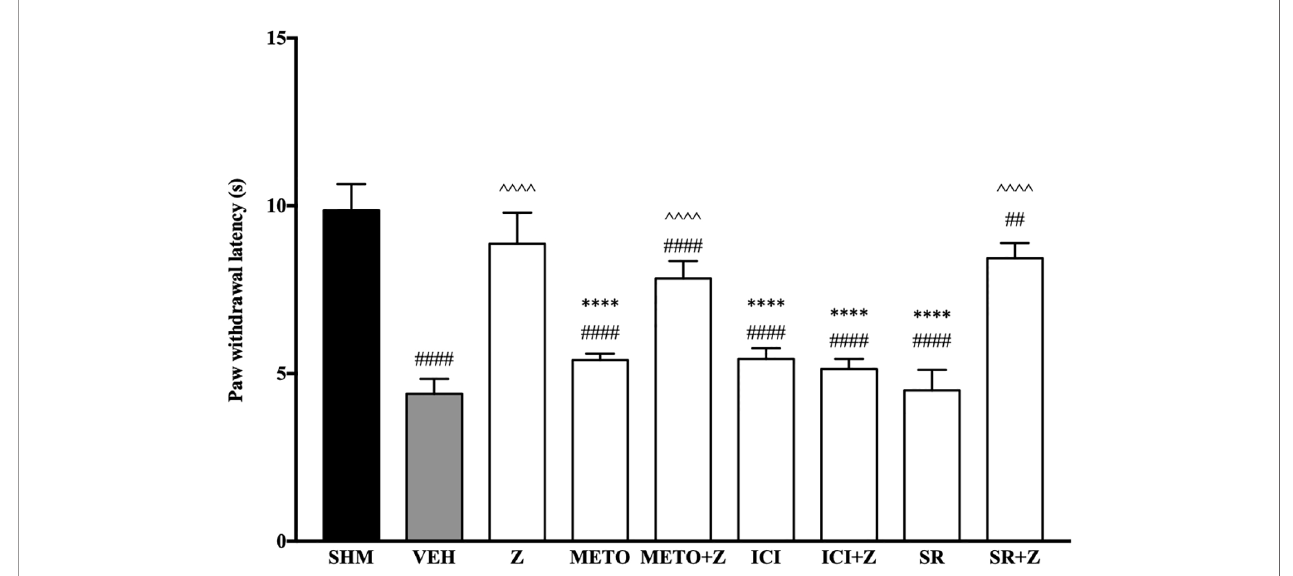
FIGURE 6 | Effect of metoprolol ( b 1 -adrenoceptor antagonist), ICI 118, 551 ( b 2 -adrenoceptor antagonist) and SR 59230 A ( b 3 -adrenoceptor antagonist) pre- treatment on zerumbone against thermal hyperalgesia in CCI-induced neuropathic pain mice. Data are presented as mean ± SEM (n = 6). ## p < 0.01, #### p < 0.0001 as compared to sham, ^^^^ p < 0.0001 as compared to vehicle and **** p < 0.0001 as compared to zerumbone-treated group. SHM (Sham); VEH (Vehicle, 10 mL/kg i.p.); Z (Zerumbone, 10 mg/kg i.p.); METO (Metoprolol, 1 mg/kg i.p.); ICI (ICI 118,551, 2 mg/kg i.p.); SR (SR 59230 A, 2.5 mg/kg